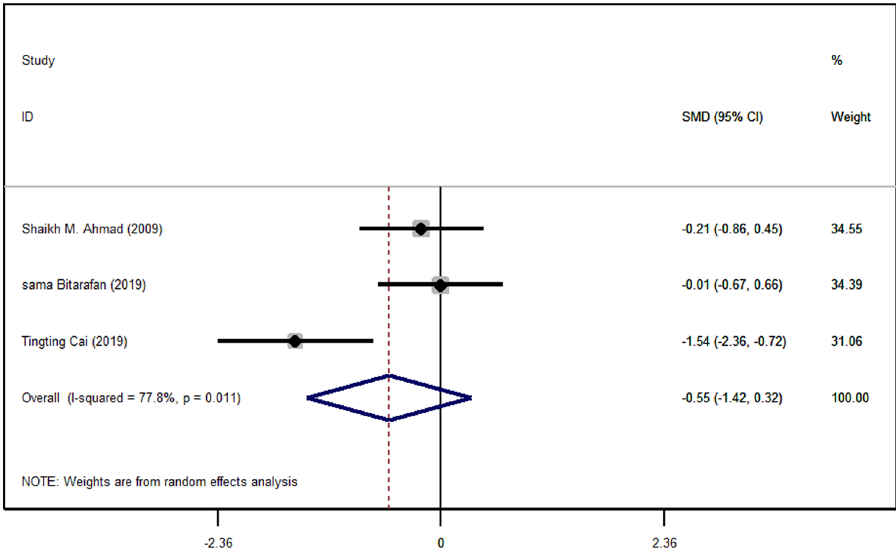
Figure 4. Forest plot for the effect of vitamin A supplementation on serum IL-6 concentrations, expressed as mean differences between intervention and control groups. Horizontal lines represent 95% CIs. IL-6 interleukin 6, SMD standardized mean difference, CI confidence